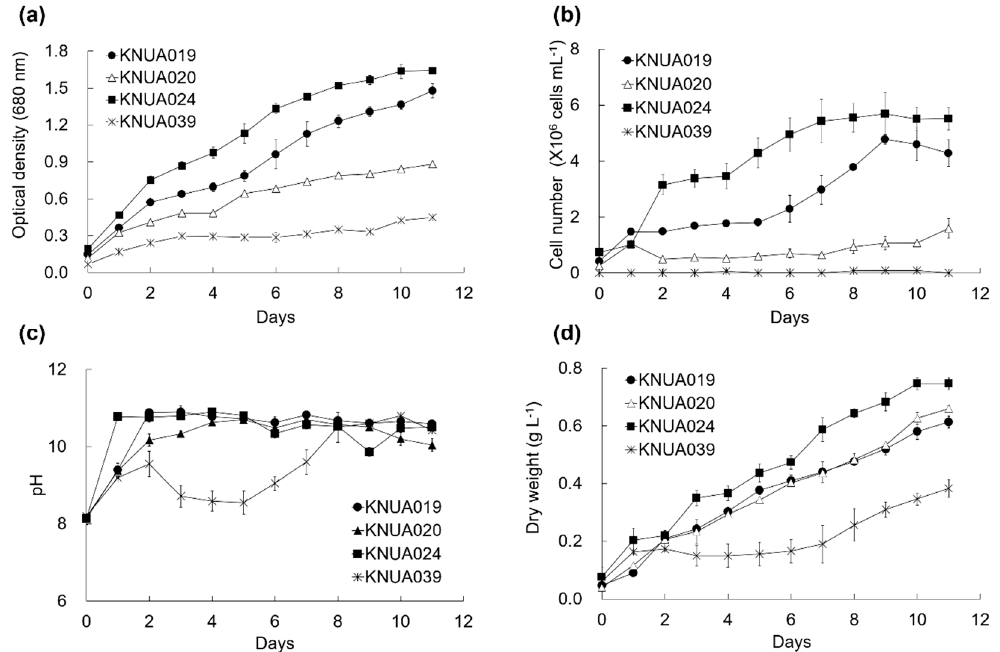
Figure 2. Growth parameters of ( a ) optical density, ( b ) cell number, ( c ) pH, and ( d ) dry weight of candidate microalgal strain in treated, primary settled wastewater.